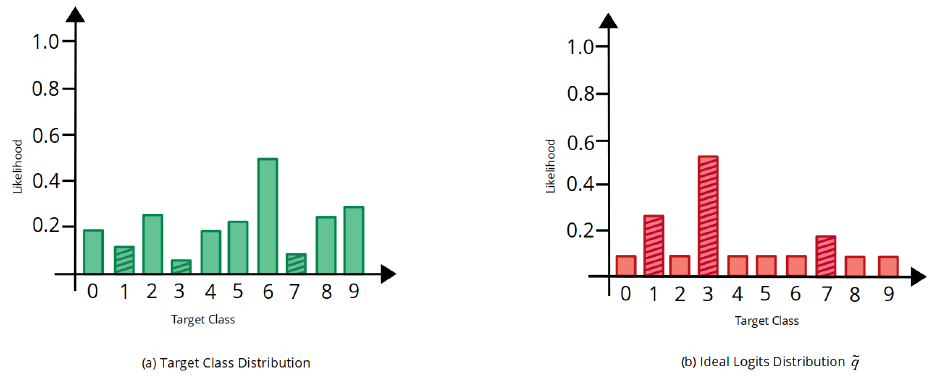
Figure 1. ( a ) Target class distribution for an imbalanced dataset consisting of 10 classes where 1, 3, and 7 represent the minority classes. ( b ) Logit weight vector ˜ q , representing the ideal case scenario where minority classes are assigned larger probabilities compared to majority classes. ˜ q is the ideal logit weight vector represented as a probability distribution. ˜ q is generated using the relative likelihood approach, a technique from the method, subjective determination of logit weight